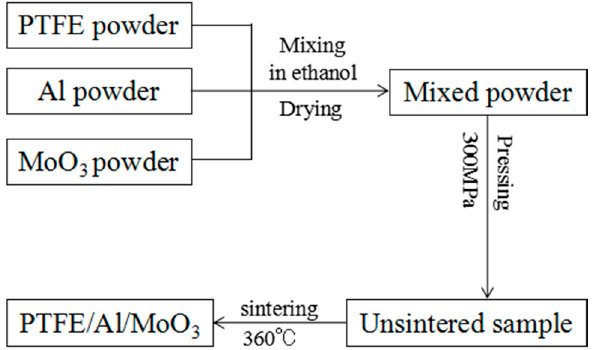
Figure 1. The preparation process of PTFE/Al/MoO 3 specimens.